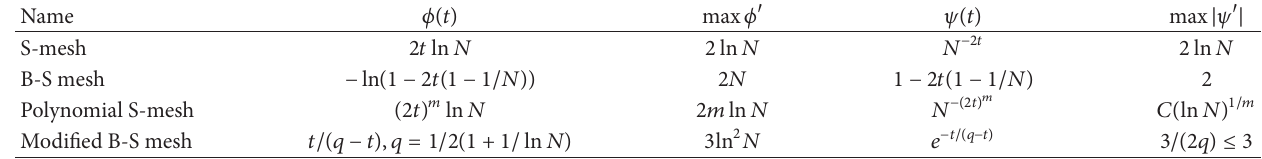
Table 1: Some examples of mesh-generating and mesh-characterizing functions of S-type meshes.